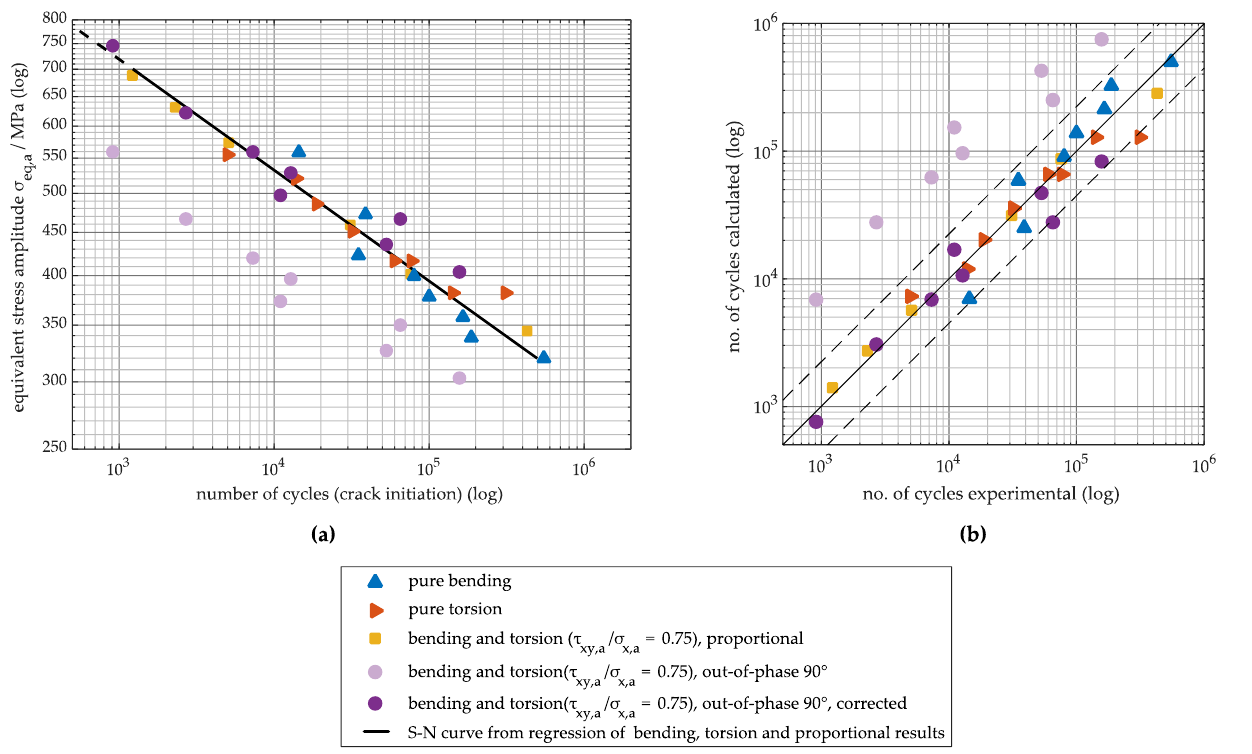
Figure 18. Test results from Figure 12 evaluated with scaled normal stresses and results for nonproportional loading corrected with factor according to Gaier et al. : ( a ) equivalent stress amplitudes according to scaled normal stresses and ( b ) number of cycles calculated based on the proportional S–N curve over an experimentally determined number of cycles.